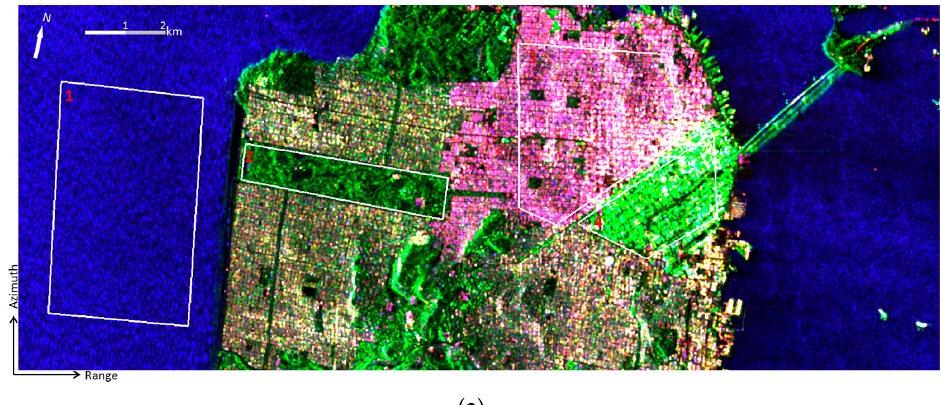
Figure 2. Cont . Figure 2.